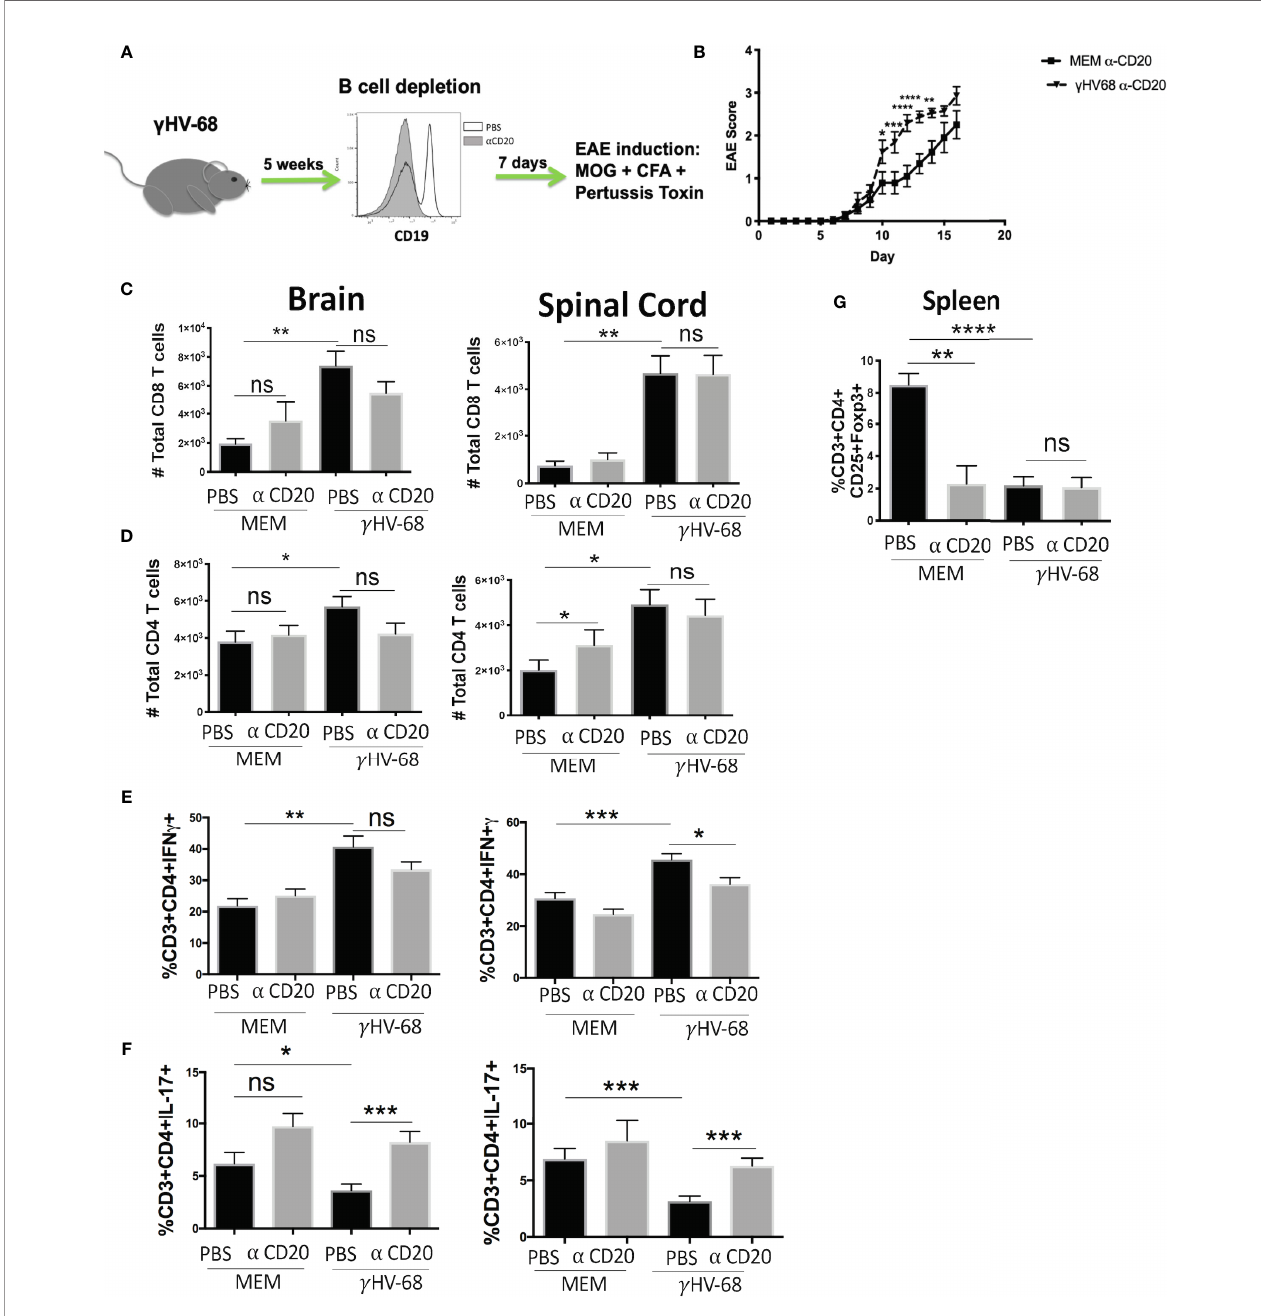
FIGURE 3 | Mice were infected with g HV-68 or MEM i.p. 5 weeks p.i. B cells were depleted with a -CD20 i.v. 2 days after depletion EAE was induced. At days 21 to 23 post EAE induction, mice were perfused; brains and spinal cords were harvested and processed to isolate immune in fi ltrates. (A) Histogram shows a representative experiment of effectiveness of B cell depletion. (B) Graph shows EAE scores up to day 23 post induction. (C) Percentage of CD8 + in fi ltrating cells in the brain and spinal cord. Data analyzed with two-way ANOVA test with Bonferroni ’ s correction for multiple comparisons: ***p < 0.001, *p < 0.05 (D) Percentage of CD4 + in fi ltrating cells in the brain and spinal cord. (E) Percentage of CD3 + CD4 + IFN g + and (F) CD3 + CD4 + IL-17 + in the brain and spinal cord. (G) Spleens were harvested and processed to isolate immune in fi ltrates. Percentage of CD3 + cells expressing CD4 + CD25 + FoxP3 + . Five independent experiments 20 to 25 mice/group. Data analyzed student ’ s t-test: ****p < 0.0001 ***p < 0.001, **p < 0.01, *p < 0.05. ns = not signi fi CD8 + T cells in the brain of g HV-68/ a -CD20 mice compared to ( Figure 2C ), and CD4 + T cells remained mostly unchanged g HV-68/PBS mice (p < 0.05). This reduction of CD8 + T cell (p=ns) ( Figure 2D ). Interestingly, we saw a signi fi cant reduction inIFN g productioninCD4 + Tcellsinthe brainandspinalcordof in fi ltration was not at the same level as MEM mice (p < 0.05)